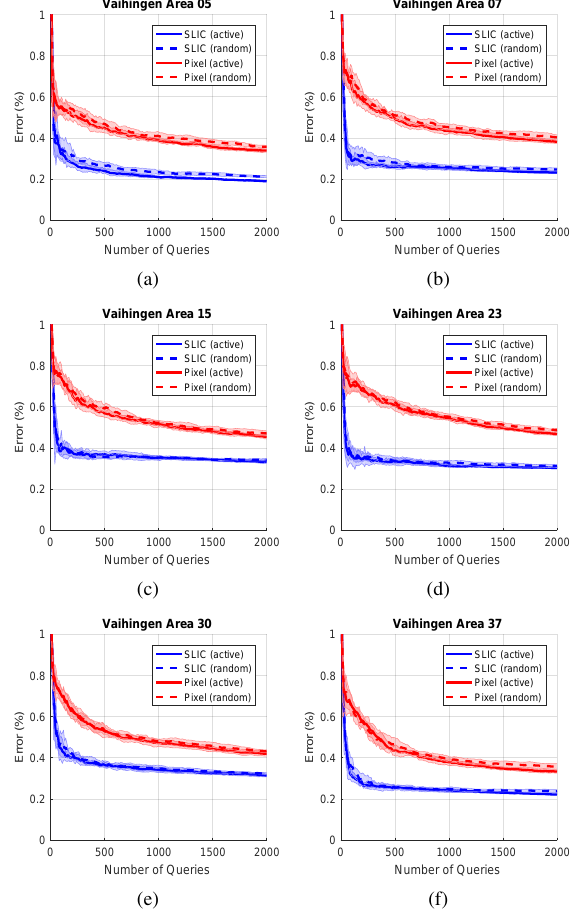
Figure 7. Comparison of the original pixel based active queries method (red) and the presented extension based on the SLIC algorithm (blue). Also shown is a comparison between random sampling (dashed lines) and active learning (solid lines). Both active learning and the handling of mixed pixels improve the classification error, but the extraction of representative pixels far outweighs the effects of the active